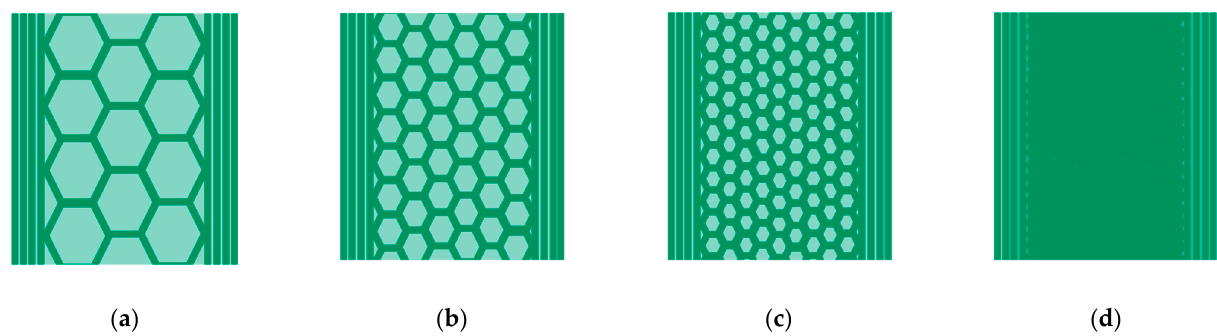
Figure 3. Sketch of the cross-sections of the used specimens. The outline of four layers remained constant while the size of the hexagonal infill structure was minified: ( a ) ID 25; ( b ) ID 50; ( c ) ID 75; ( d ) ID 100.